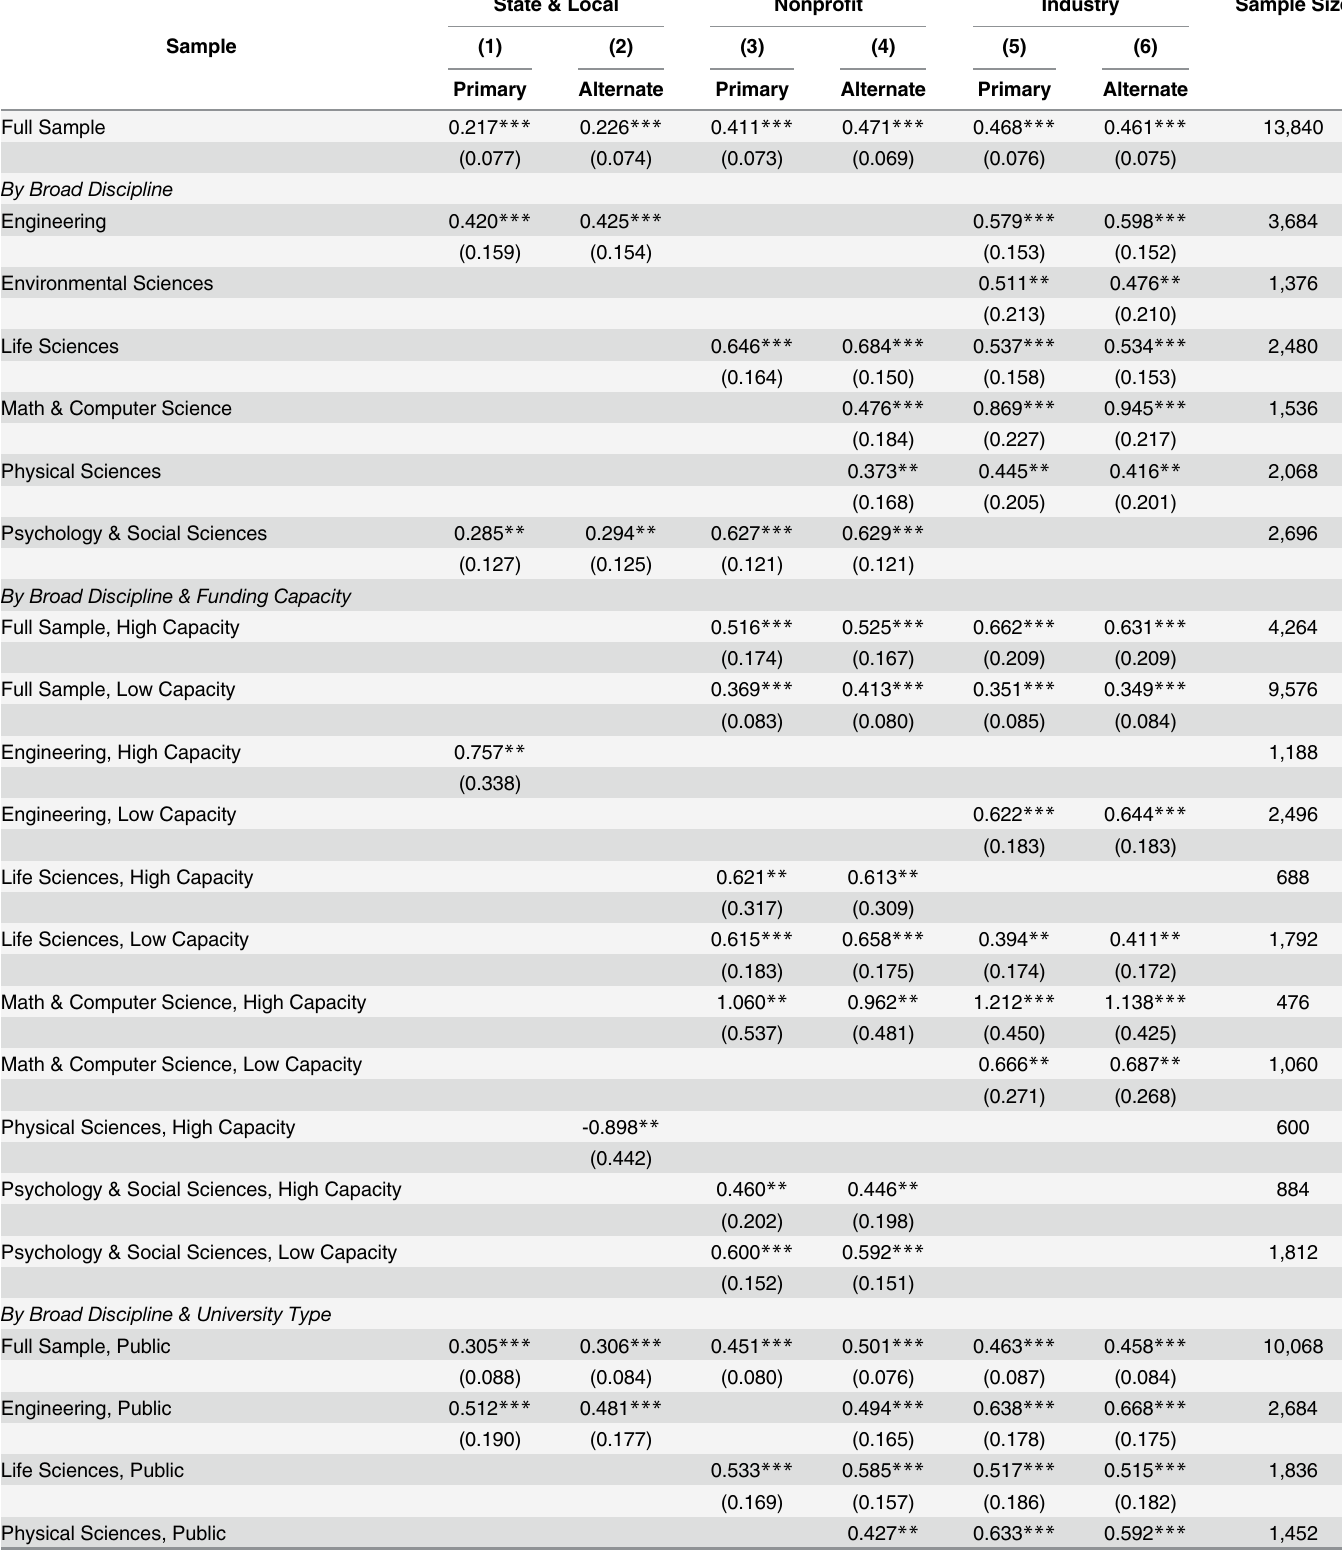
Table 9. Comparison of Endogenous vs. Predetermined Controls across Outcomes and Stratifications (Eq 1 & Eq